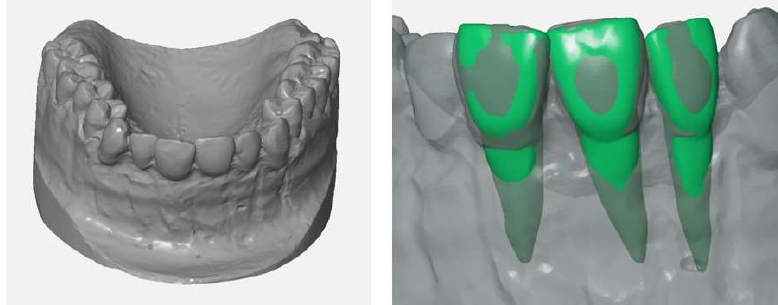
Figure 2. Scanned surface of the plaster cast without wax layer ( left ) and the meshes of the three teeth aligned to the upper jaw ( right ).